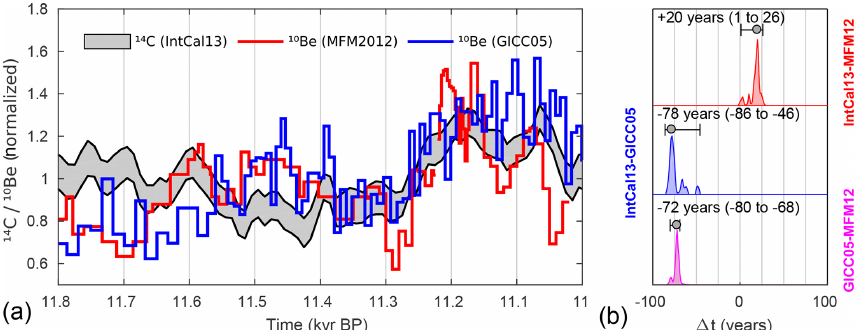
Figure 2. Results from the Bayesian wiggle matching of the different radionuclide records. Panel (a) shows both the MFM 10 Be data (in red) and the GRIP 10 Be data (blue) once synchronized to the 14 C production rate data inferred from the IntCal13 calibration curve (1 σ gray envelope). Panel (b) displays the probability density functions for the best fit between IntCal13 and MFM2012 (in red), IntCal13 and GICC05 (in blue), and GICC05 and MFM2012 (in magenta), which resulted in the synchronization in panel (a) with a 95.4% confidence interval illustrated by the horizontal error